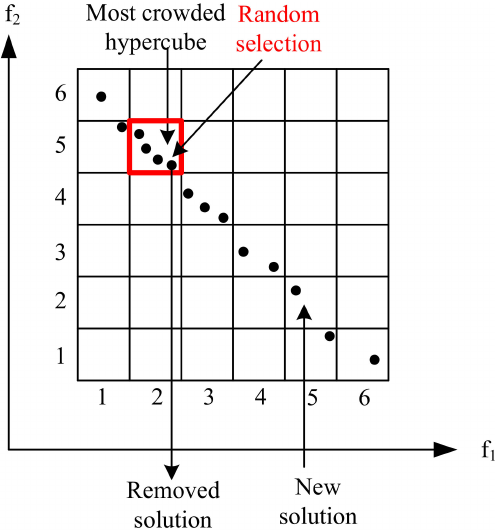
Figure 3. Insertion of an NDS when the external archive is